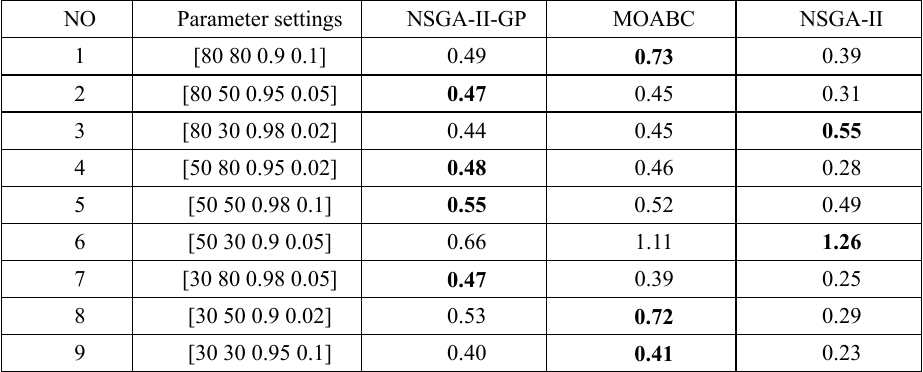
Table 3. Comparison of MHV values of three algorithms with different